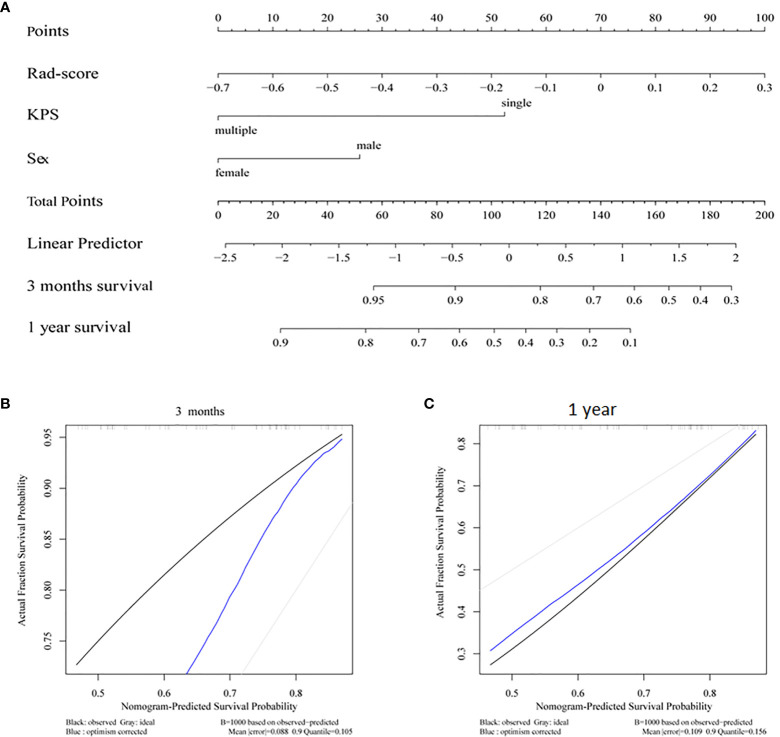

(A) Radiomics nomogram integrated with radiomics signature and clinical factor; calibration curves of the radiomics nomogram for (B) 3 months survival and (C) 1 year survival.